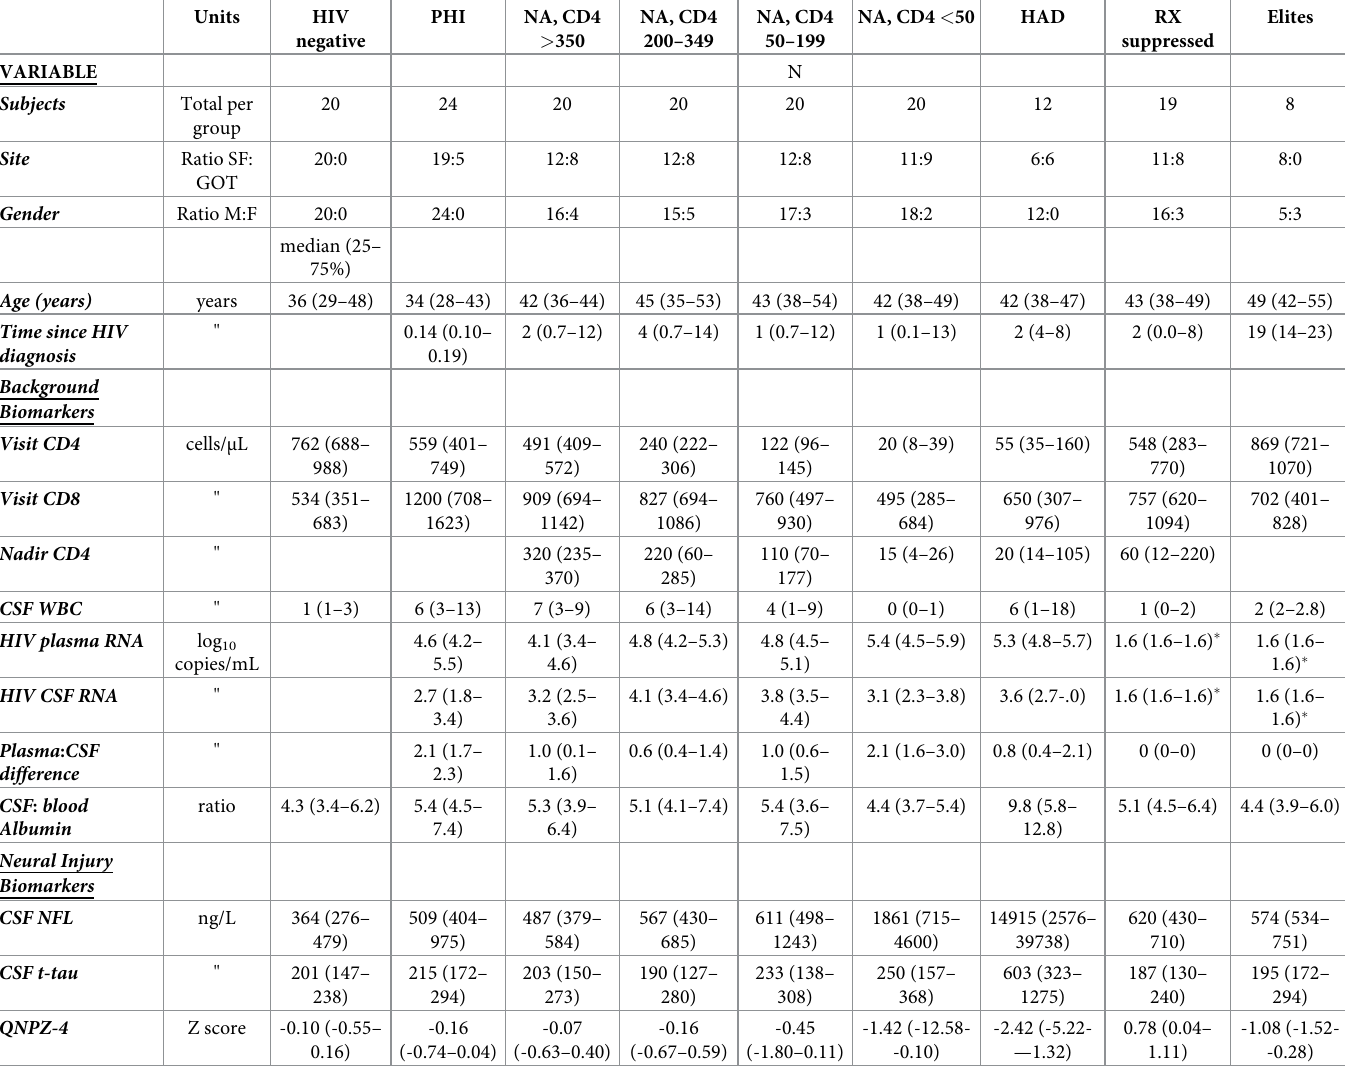
Table 1. Background characteristics of the 9 subject